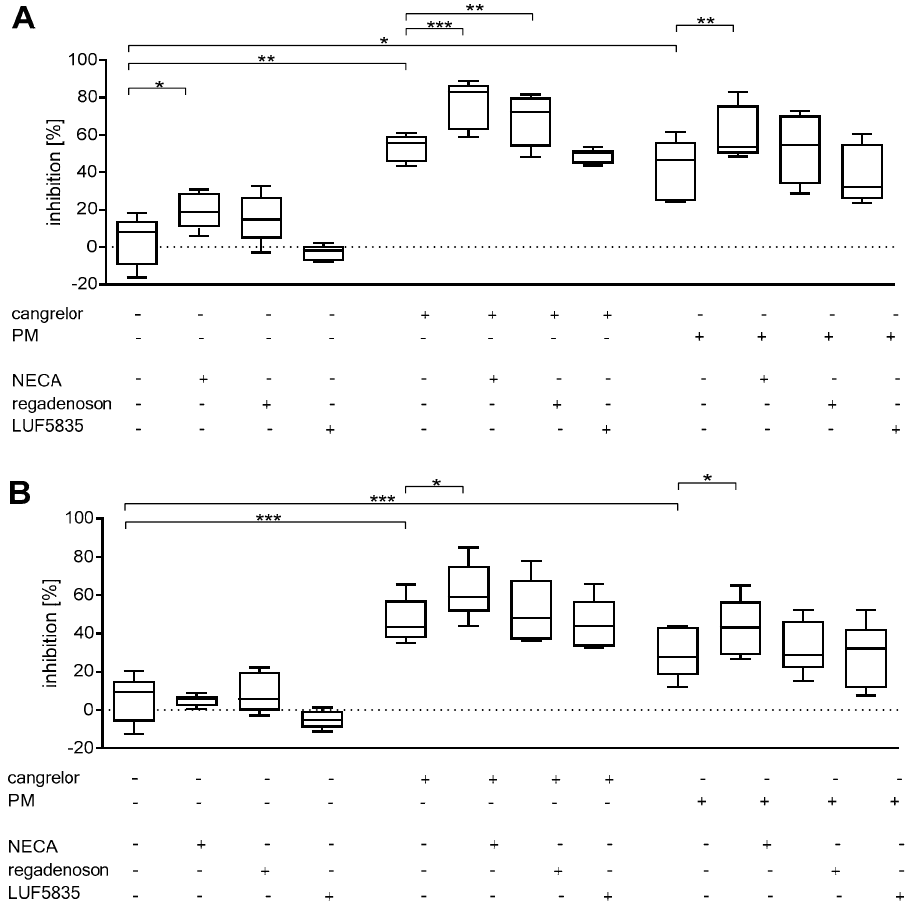
Figure 4. AR agonists deepen the P2Y 12 inhibitory e ff ect on platelet reactivity as measured by P-selectin expression ( A ) and PAC-1 binding ( B ). Data are given as median, interquartile range, and minimum and maximum values ( n = 5). Changes in platelet reactivity were measured in whole blood in response to 20 µ M ADP after 3 min preincubation at 37 ◦ C with AR agonist and cangrelor, or 15 min preincubation at 37 ◦ C with PM. Statistical significance estimated by repeated measures ANOVA with Bonferroni’s multiple comparison test or Friedman’s test with Dunn’s multiple comparison test depending on the data distribution. * p < 0.05, ** p < 0.01, *** p < 0.005.